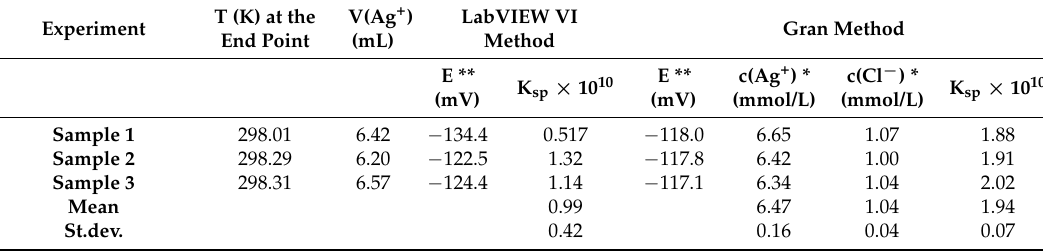
Table 2. Results at the end point of a precipitation titration of three replicates of a 40.00 ± 0.04 mL sample of fresh river water at 298 K by using the LabVIEW VI method versus the Gran